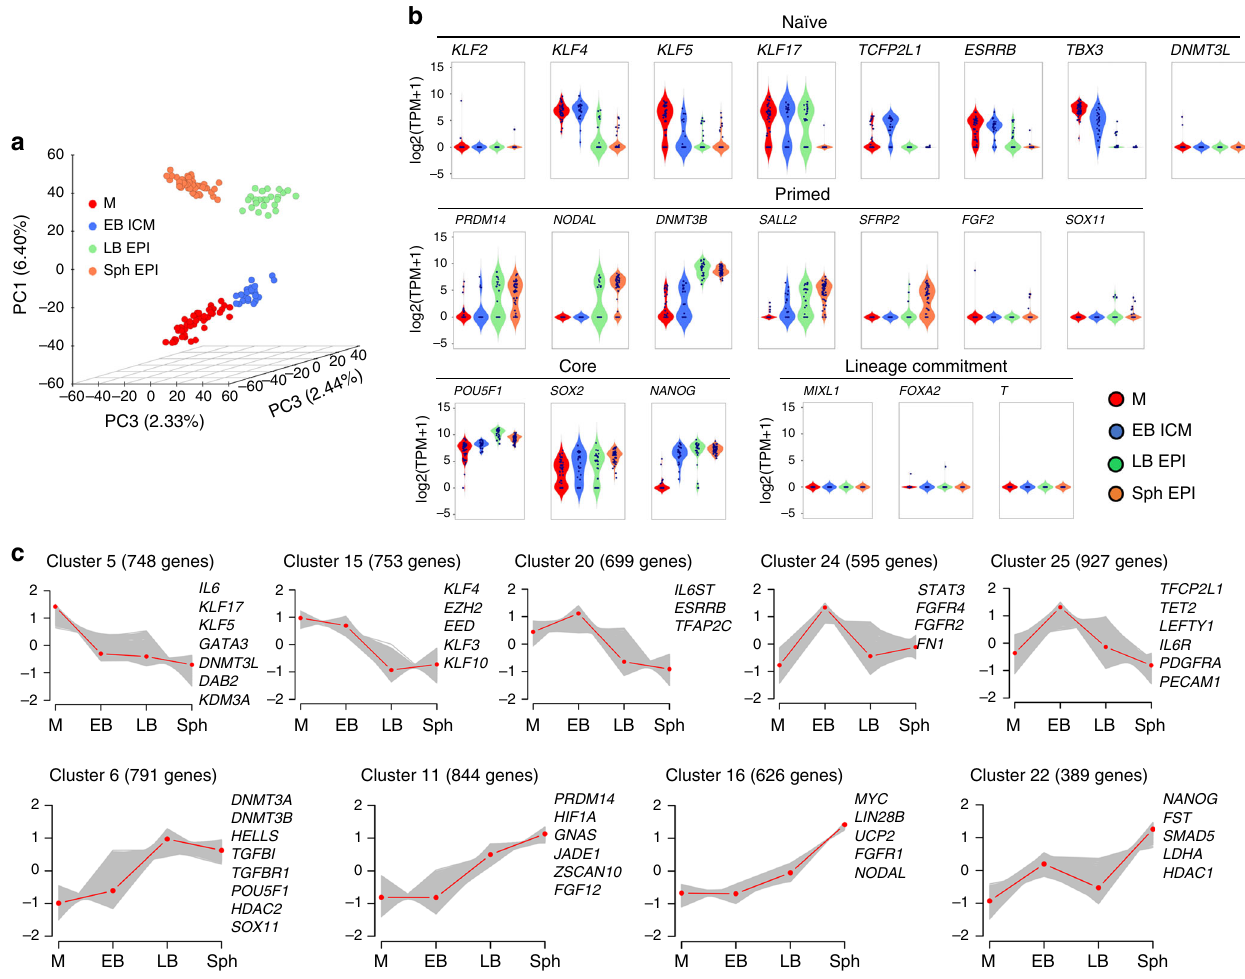
Fig. 4 Progression of pluripotency in the pig embryo: a Principal component analysis (PCA) of the pluripotent lineages ( n = 144 cells). b Violin plots of the expression of selected pluripotency and lineage speci fi er genes. c Self-organising maps (from a total of 25) showing key genes representative of naive and primed pluripotent